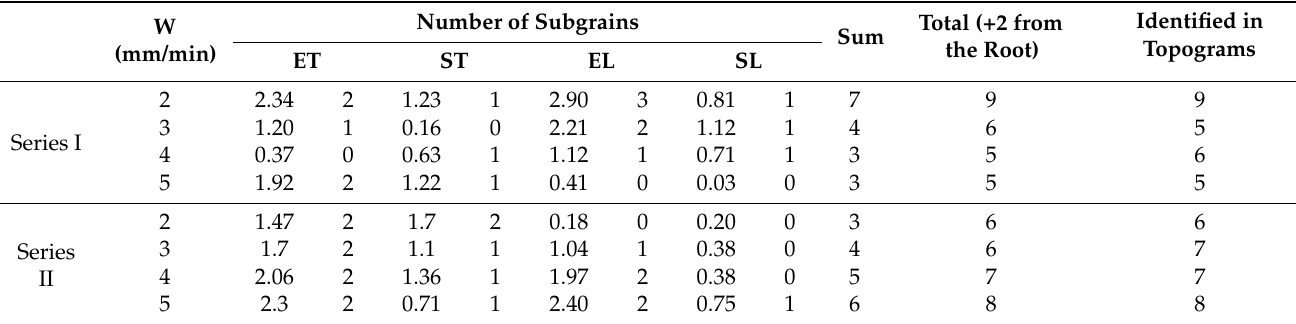
Table 3. The number of LABs defined by calculations and from X-ray topograms for airfoils of blades obtained in two series at the withdrawal rates of 2, 3, 4 and 5